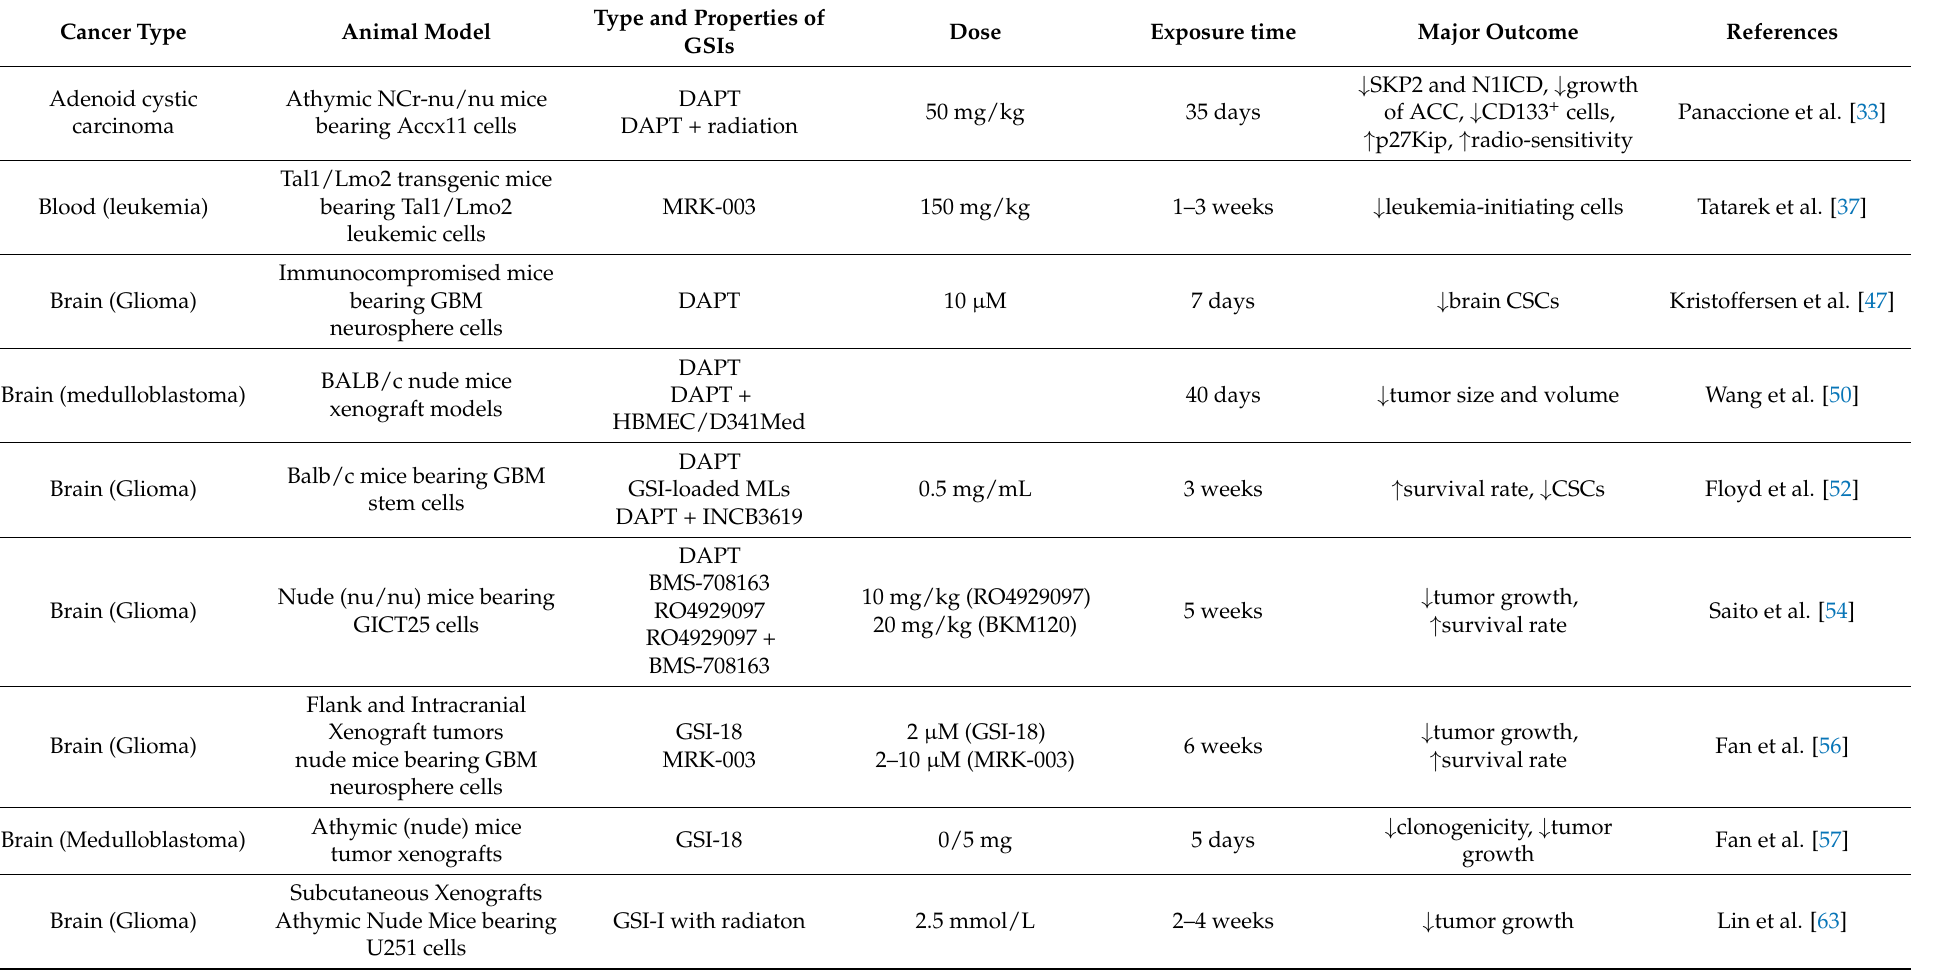
Table 2. Potential anti-CSC effects and related mechanisms of action of GSIs based on in vivo